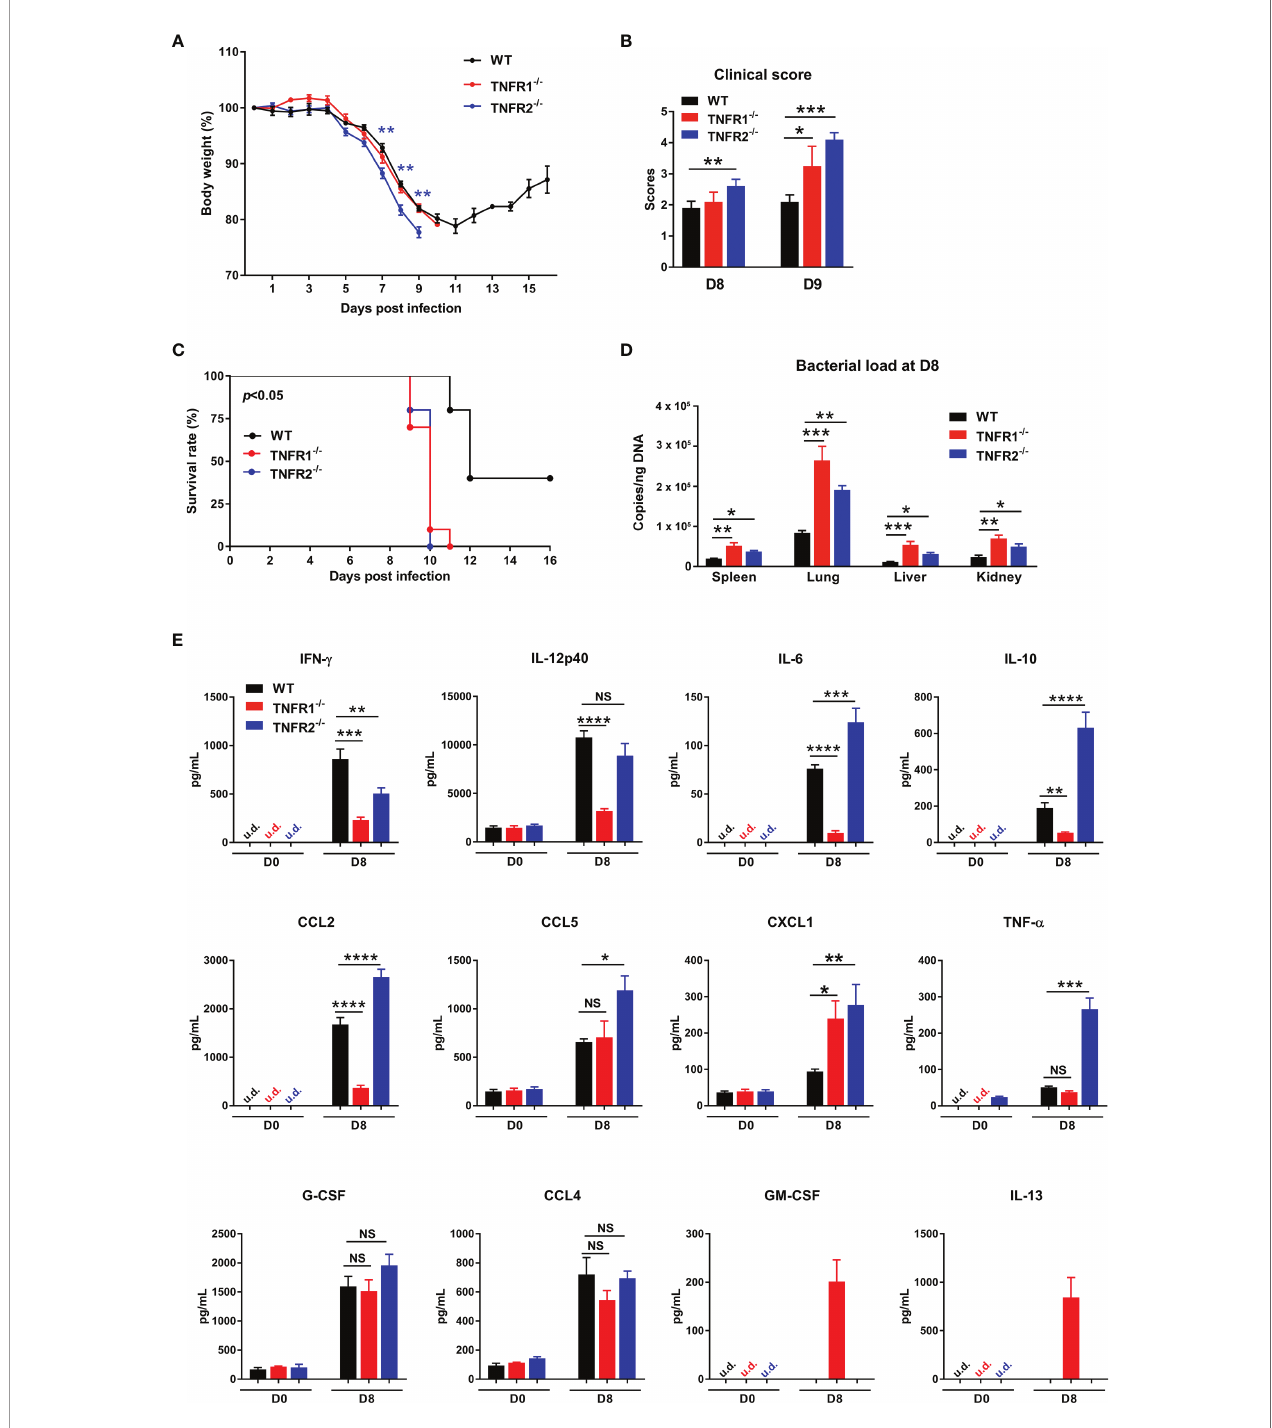
FIGURE 7 | Both TNFR1 and TNFR2 were required for host protection against infection. WT, TNFR1 -/- and TNFR2 -/- mice (10/group) were infected i.v. with 6 × 10 4 FFU of bacteria. (A) Body weight changes, (B) clinical scores, and (C) survival curves were recorded. (D) Bacterial loads in various organs at D8 were measured by qPCR (4-5 mice/group). (E) Serum chemokine/cytokine pro fi le was analyzed by Bioplex assay. Data are shown as mean ± SD from single experiments and are representative of at least two experiments performed. A one-way ANOVA with a Tukey ’ s multiple comparisons test was used for statistical analysis. Survival data were analyzed using a log-rank (Mantel-Cox) test. Blue stars in (A) represent the comparison between WT and TNFR2 -/- groups. * p <0.05; ** p <0.01; *** p <0.001; **** p <0.0001; NS, not signi fi